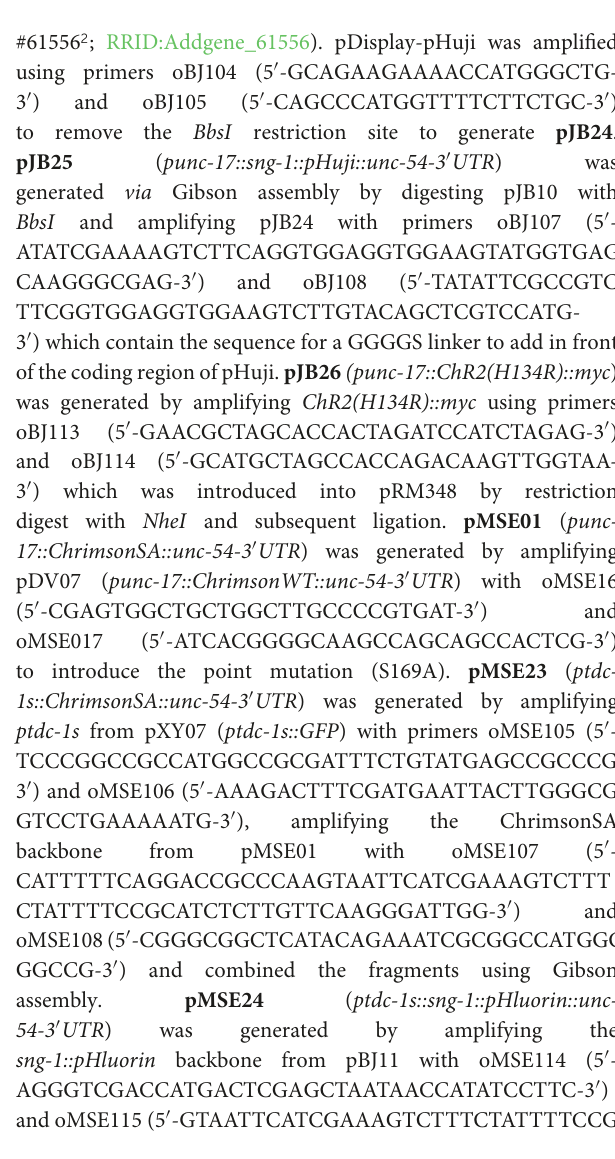
measurement of postsynaptic effects using electrophysiology, Ca 2 + imaging, or by (non-)time-resolved EM (Liewald et al.,